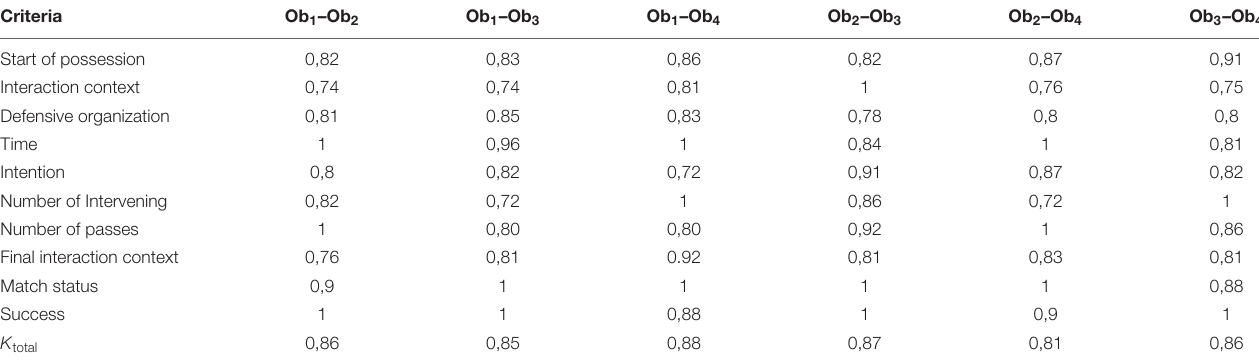
TABLE 1 | The interobserver agreement analysis for each